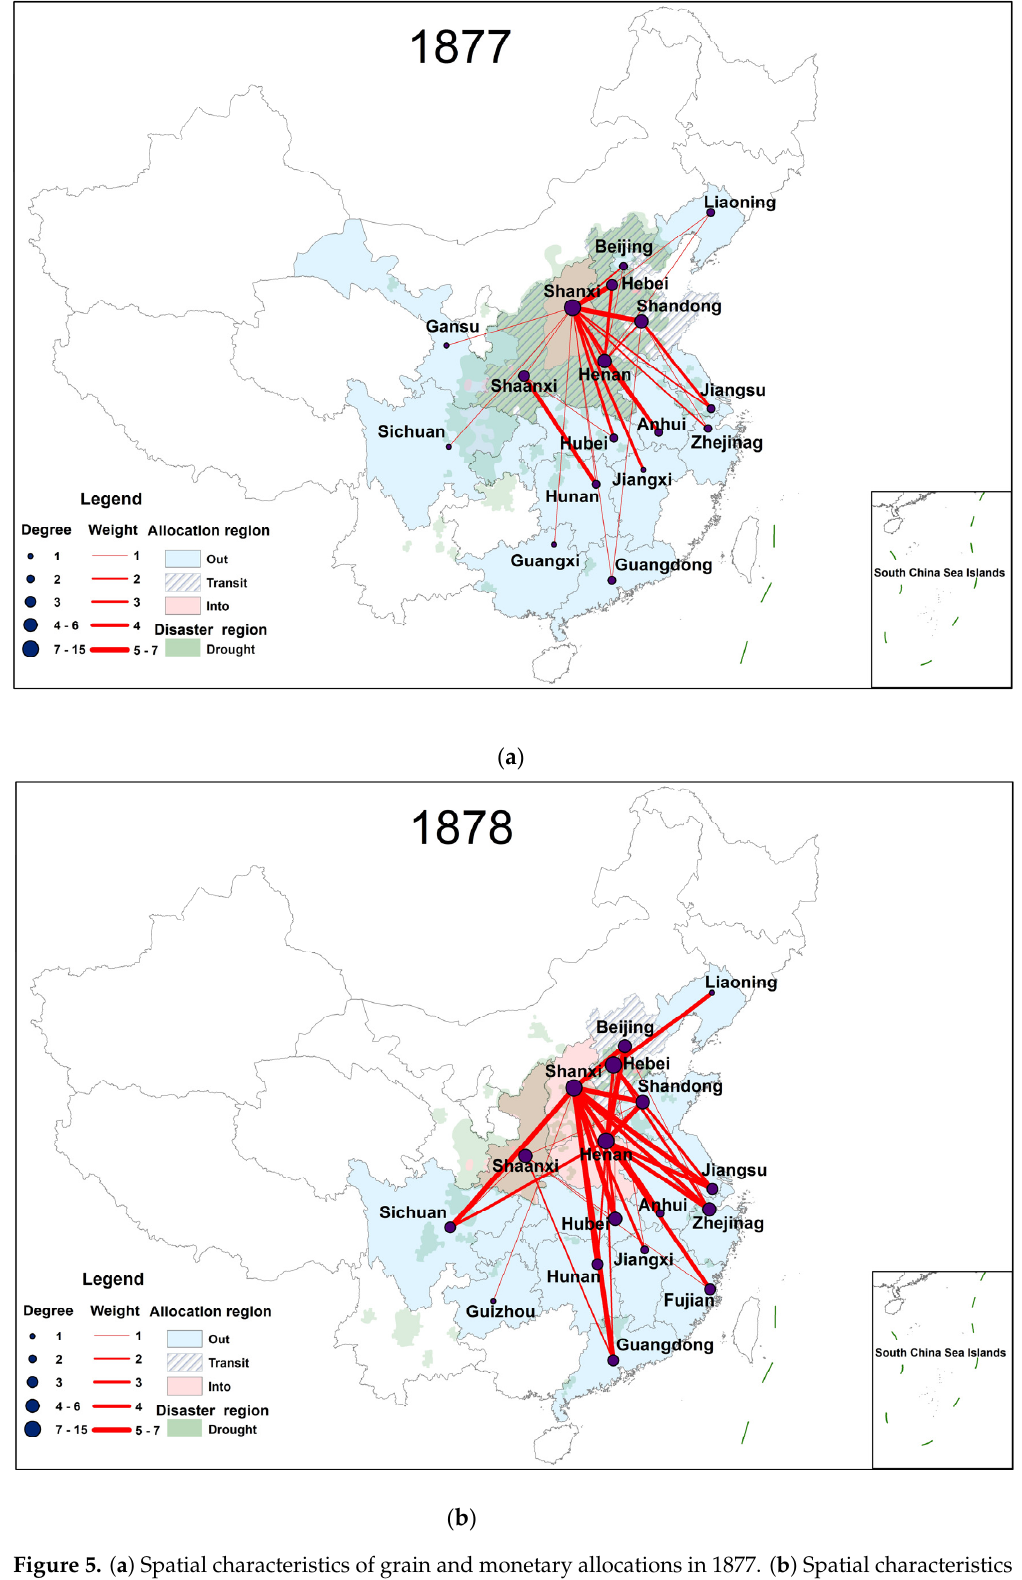
Figure 5. ( a ) Spatial characteristics of grain and monetary allocations in 1877. ( b ) Spatial characteristics of grain and monetary allocations in 1878. Degree: the number of direct links connected with a node; Weight: the number of inter-provincial transfers.